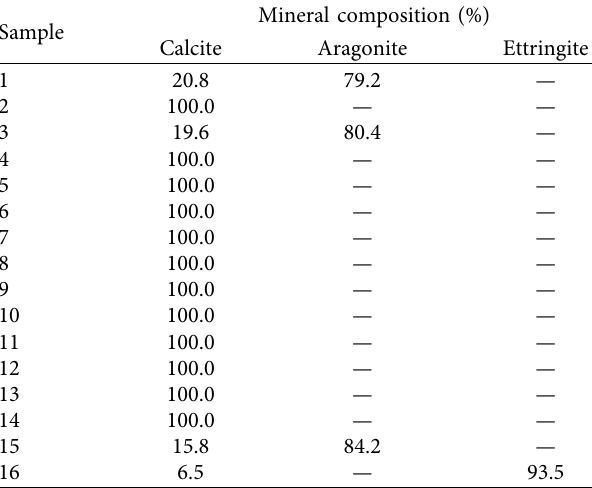
Table 1: Sample minerals content